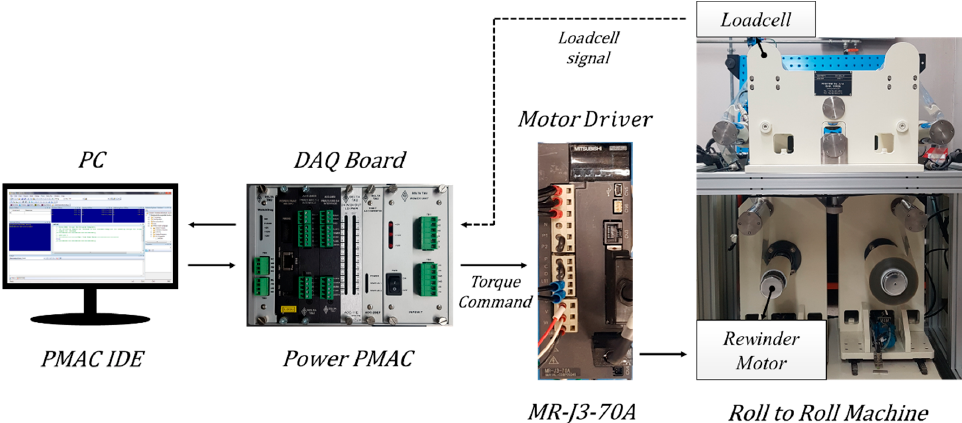
Figure 8. Overall control system for R2R system.